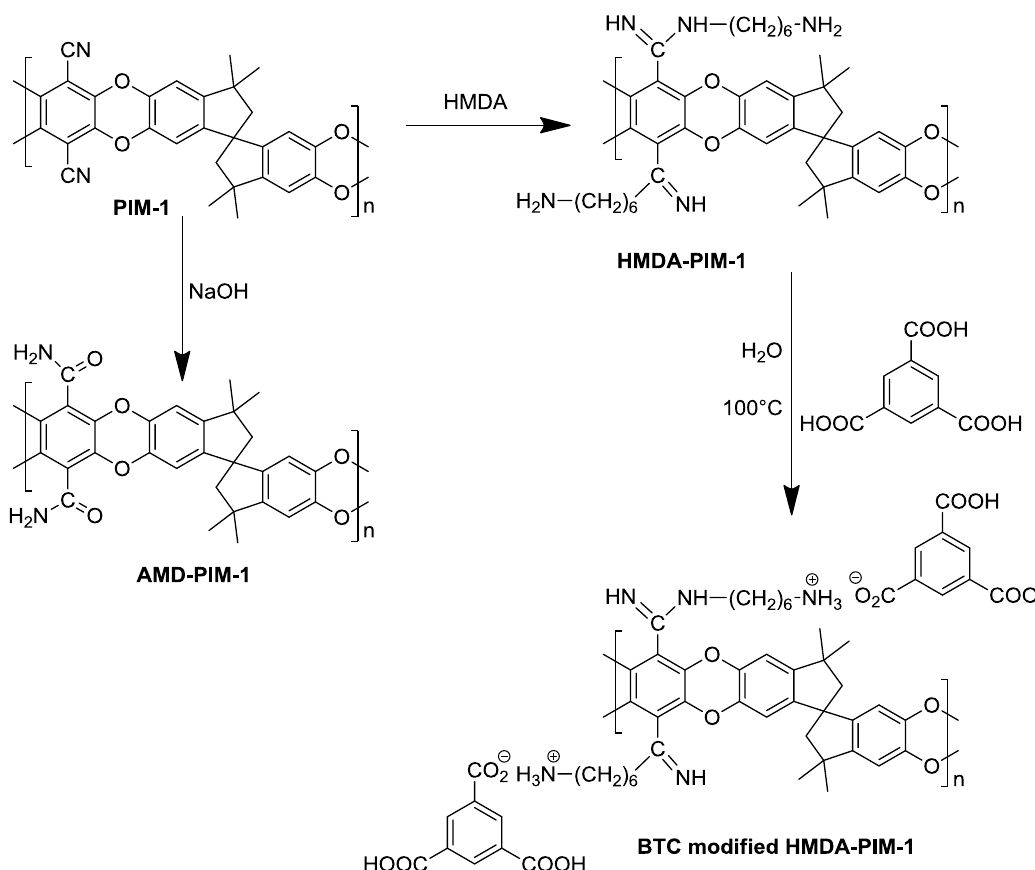
Figure 1. Functionalization of Polymer of Intrinsic Microporosity (PIM-1) to Amide (AMD)-PIM-1 by conversion of the nitrile group to an amide group. Possible products formed upon reaction of PIM-1 to HMDA-PIM-1 by conversion of the nitrile group to the imine, and further BTC modification of HMDA-PIM-1. An alternative reaction to the aminohexamethylamide (Ar-C(O)NHR, not shown) could take place simultaneously.